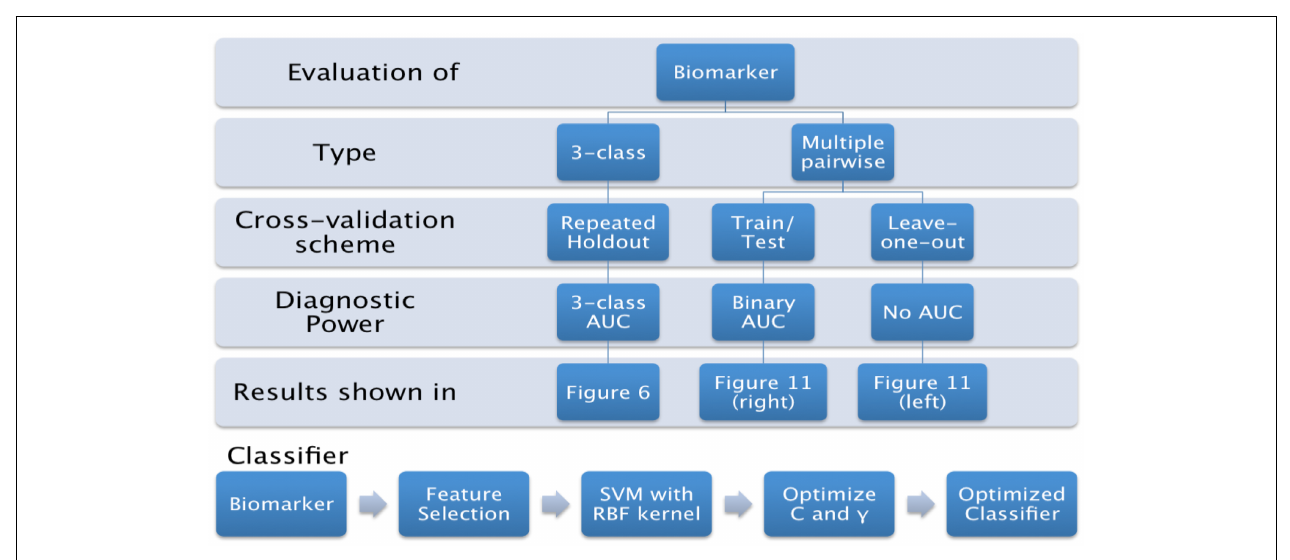
FIGURE 4 | List of experiments presented in this study, and link to the related figures .